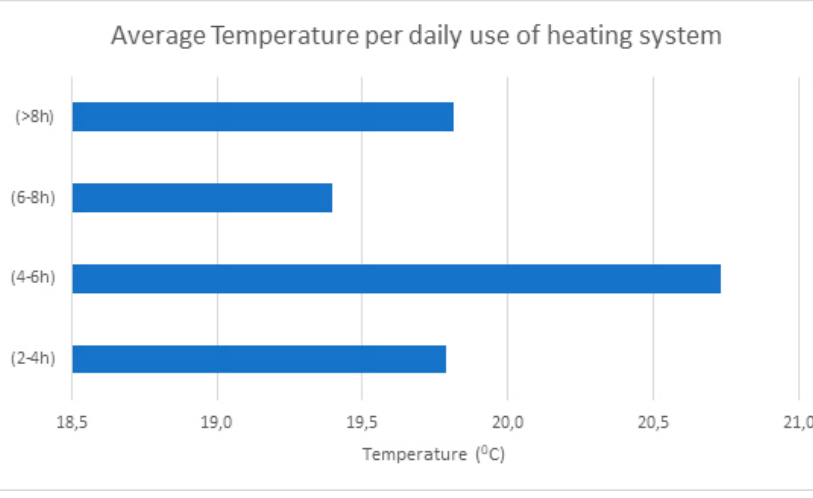
Figure 5. Average indoor temperature compared to the daily use of heating systems.